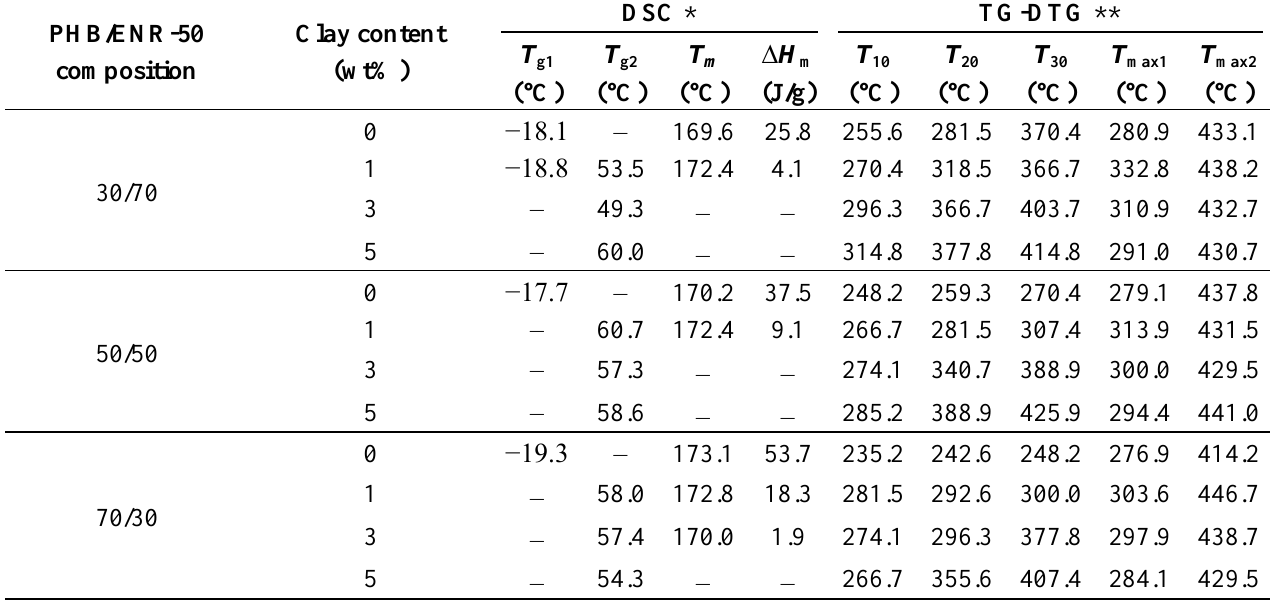
Table 2. Thermal transition (DSC ) and thermal decomposition (TG-DTG) data of PHB/ENR-50 (30/70, 50/50 and 70/30) blends and respective nanohybrids containing 1, 3 and 5 wt%